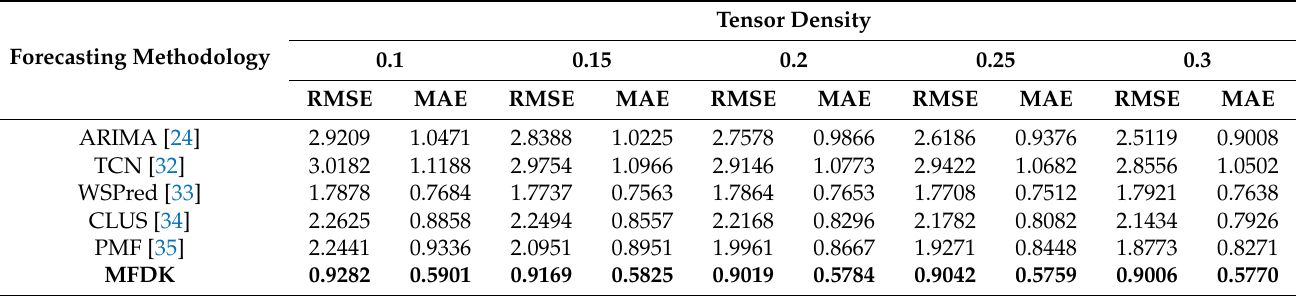
Table 2. Results of model comparison